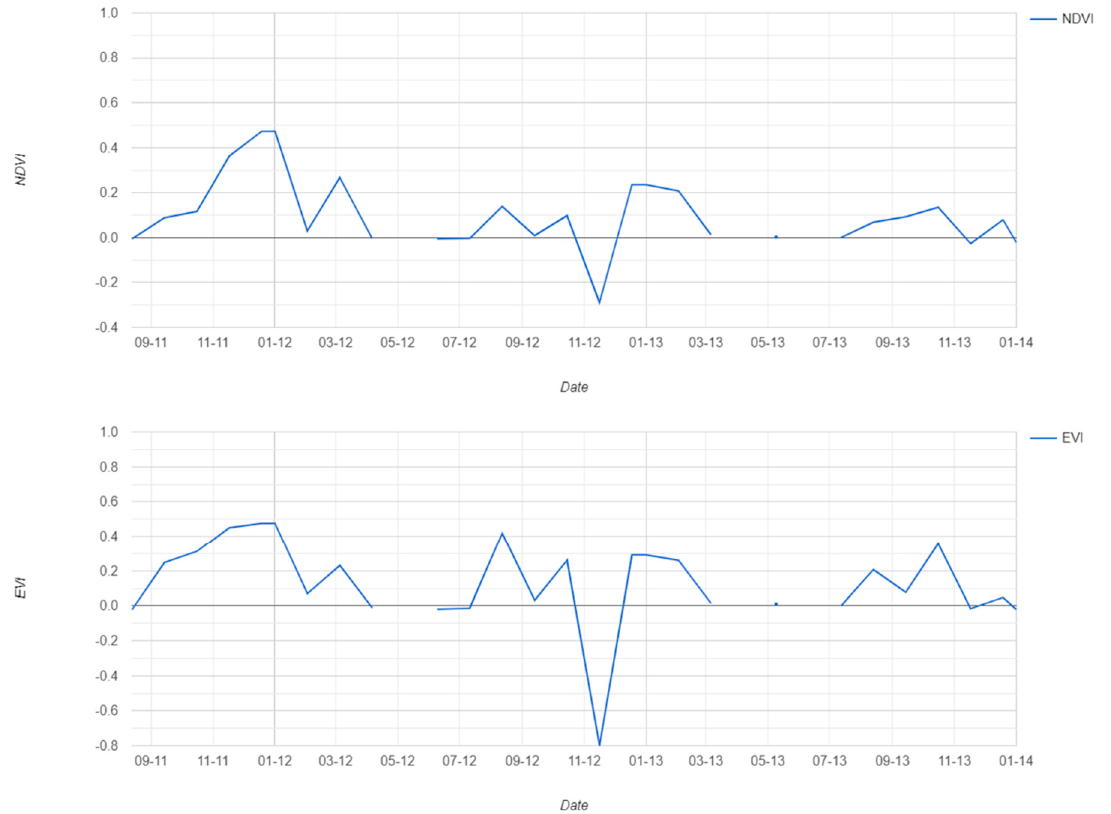
Figure 3. Time-series median value of Normalized Difference Vegetation Index (NDVI) in the Cascajo Wetlands, measured by the Landsat 7 Enhanced Thematic Mapper (ETM).